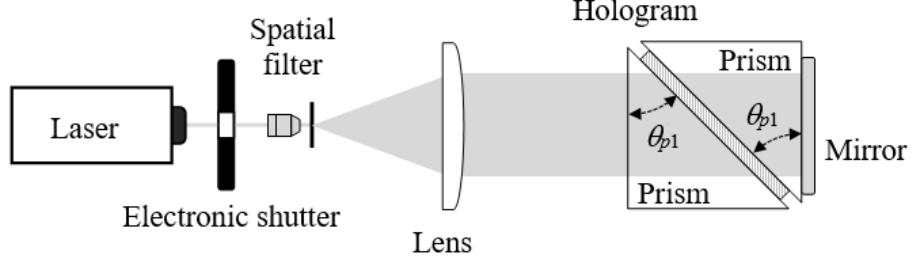
Figure 4. Prism-hologram-prism sandwiched recording setup.